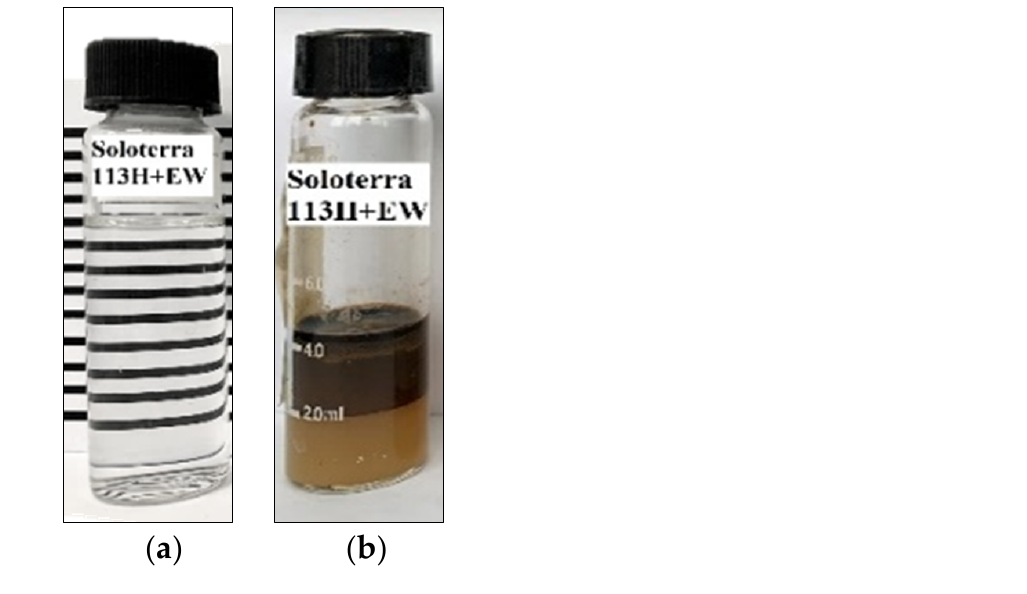
Figure 3. Results of ( a ) aqueous stability test and ( b ) phase behavior study at 80 °C for 1 wt% Soloterra-113H prepared in EW.